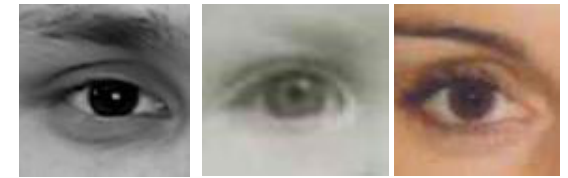
Figure 3. A greyscale image of an eye.